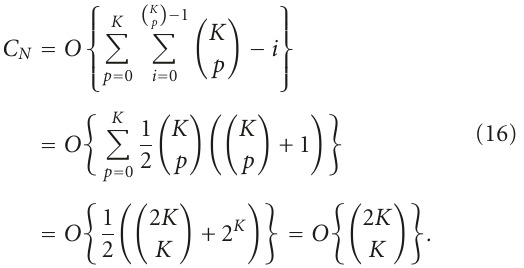
is still not partitioned. In this ordered set consider the